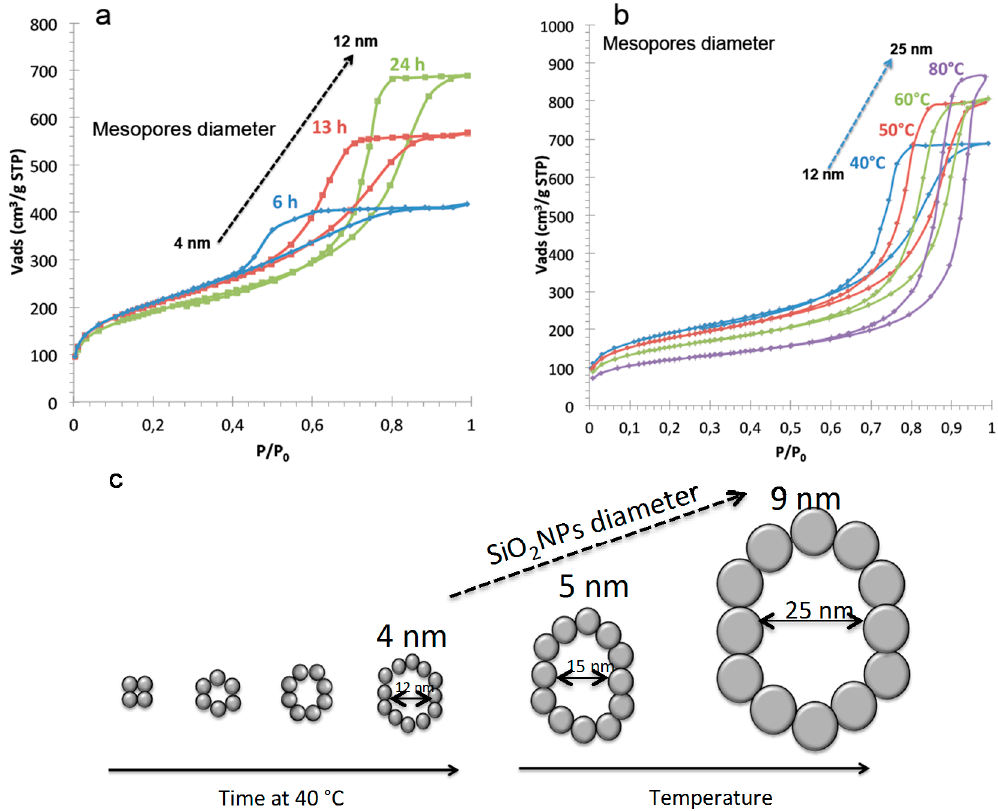
Figure 5. Nitrogen sorption isotherms at 77 K of hierarchical silica monoliths prepared with basic (NH 4 OH) treatment ( a ) at 40 °C for different time; ( b ) for 24 h at different temperature; and ( c ) Schematic representation of the evolution (size and organization) of the silica nanoparticles inside the skeleton of the monolith during basic treatment.